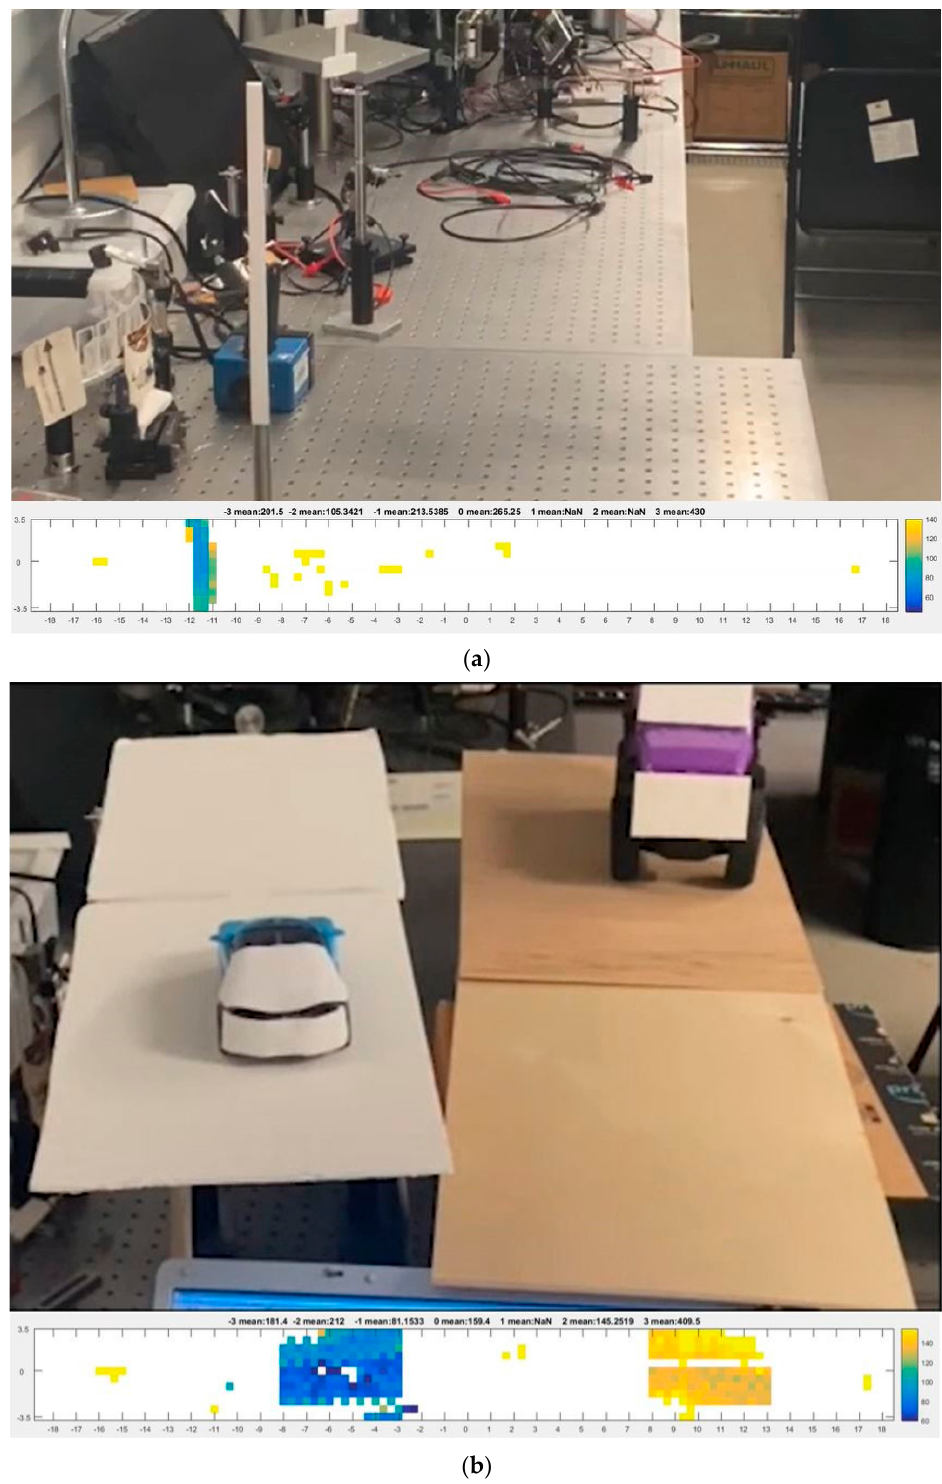
Figure 13. Video footage of ( a ) lateral translation of a bar-like target and its corresponding lidar image reconstruction; see Video S1. ( b ) Axial translation of two toy cars moving in opposite directions and the corresponding lidar image reconstruction; see Video S2.